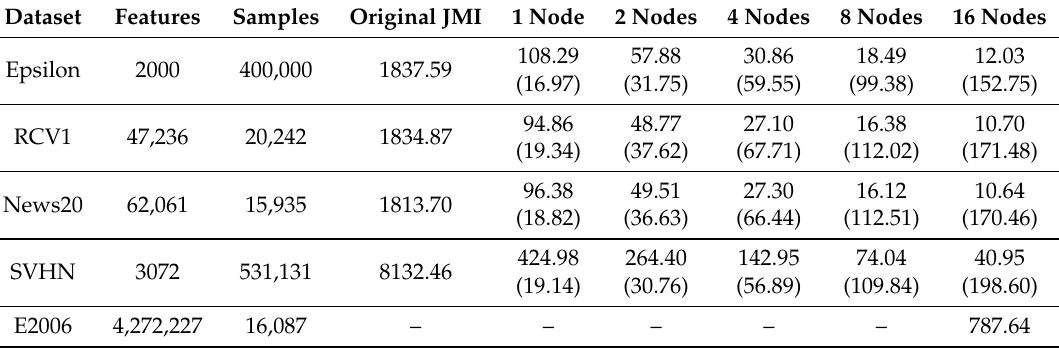
Table 1. Dataset properties, execution times (in seconds), and speedups (in parentheses) to select 200 features with